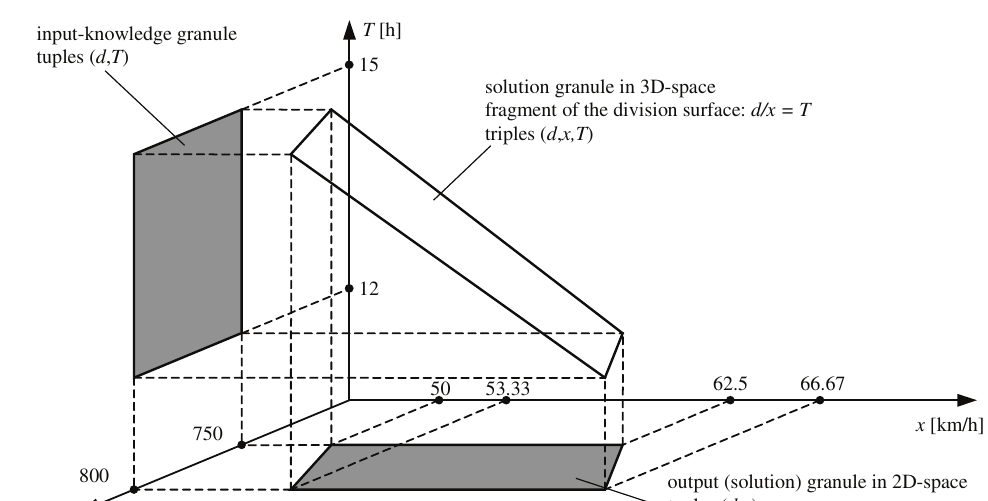
Fig. 7. Visualization of the IPVs division operation d / x = T (backward-calculation type) in the 3D-space D × X × T .